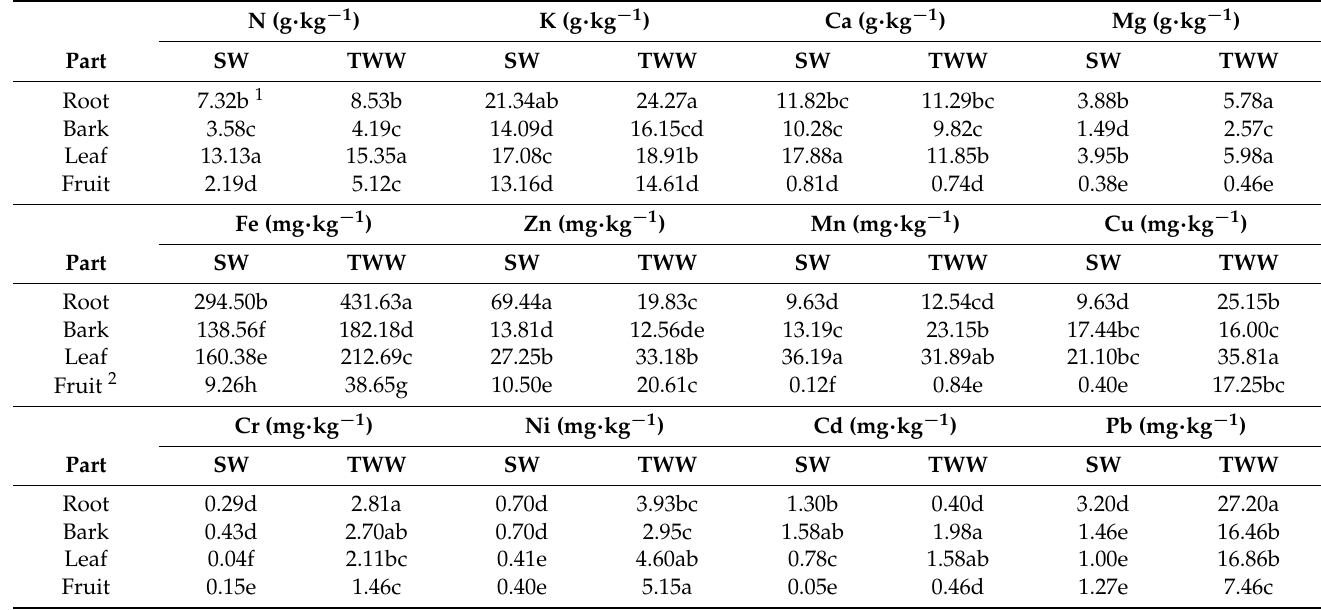
Table 5. Concentration of nutrients and heavy metals in the roots, stem bark, leaves, and fruits of lemon trees irrigated continuously with treated wastewater (TWW) and spring water (SW) at both experimental